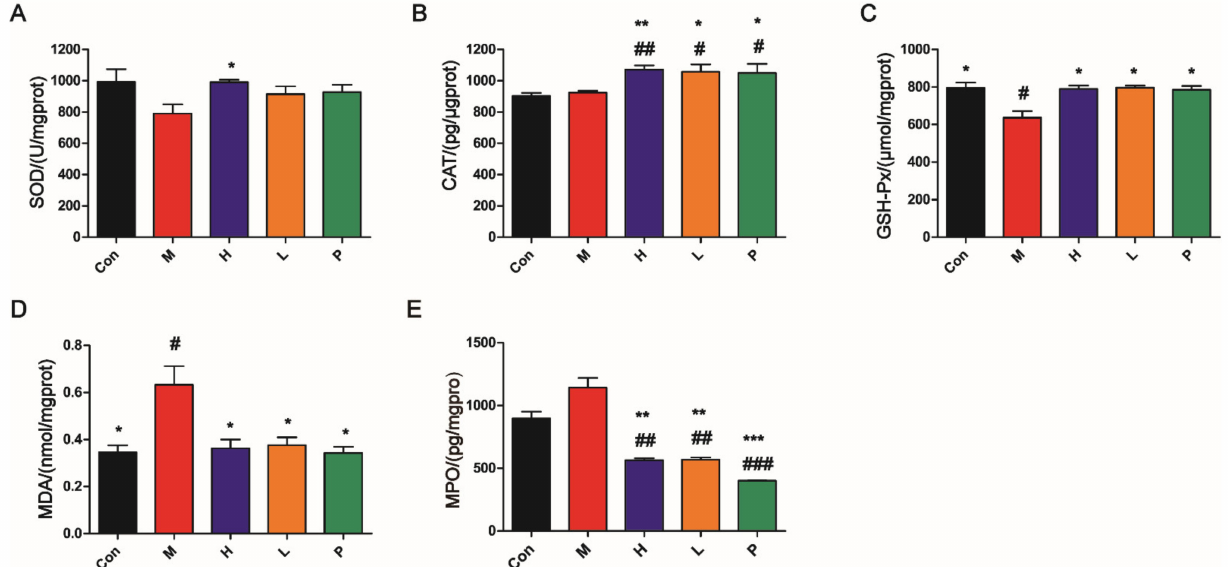
Figure 7. OPA suppressed oxidative stress in vivo. ( A – C ) Effects of OPA on SOD ( A ), CAT ( B ), and GSH-Px ( C ) (antioxidant enzyme) in liver; ( D ) effects of OPA on MDA (maker of oxidative stress) in liver; ( E ) effects of OPA on MPO in colon. Con was control group, M was model group, H was the high dose OPA group, L was low dose OPA group, P was positive group. Data were expressed as the mean ± SD, the statistical analyses were done with t -test; *** p < 0.001, ** p < 0.01, * p < 0.05 compared with the model group; ### p < 0.001, ## p < 0.01, # p < 0.05 compared with the control